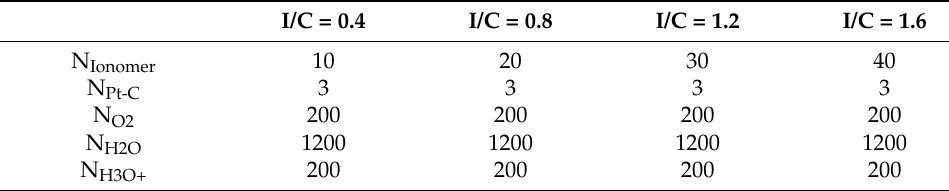
Table 2. Molecule numbers in models with different ionomer-to-carbon ratios.